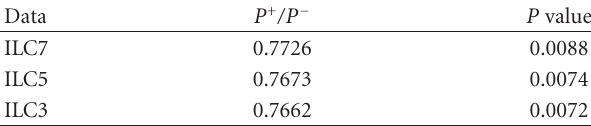
Table 2: The parity asymmetry of WMAP ILC maps (2 ≤ l ≤ 22). Data